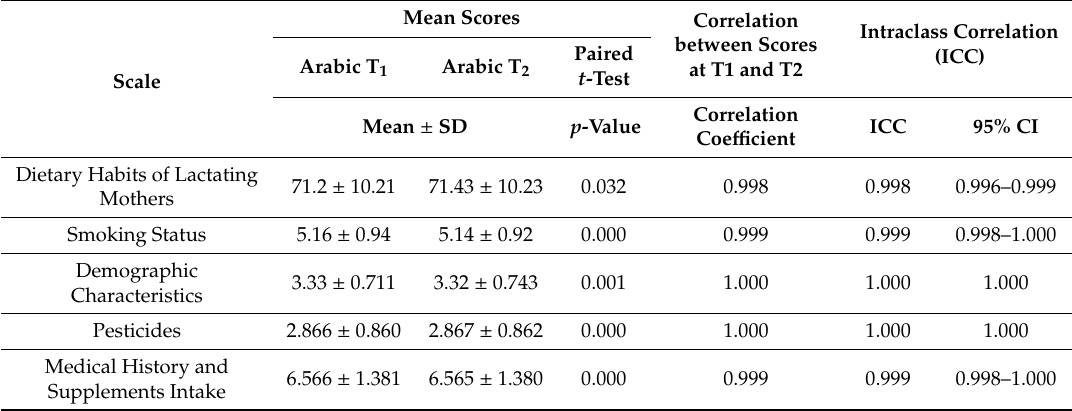
Table 2. Mean and standard deviations, Pearson’s correlation coe ffi cients and intraclass correlation for the scores of the Arabic and Arabic versions ( n =